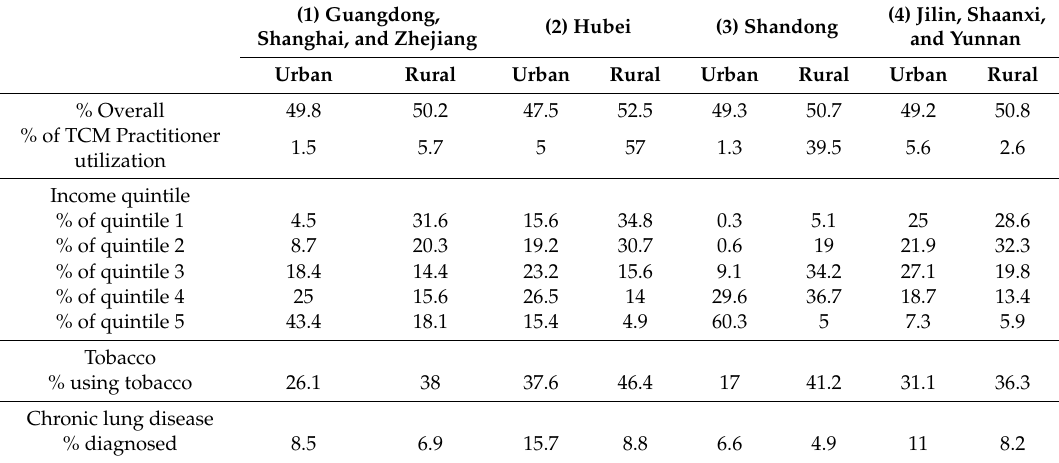
Table 4. Proportions of respondents by provinces and major